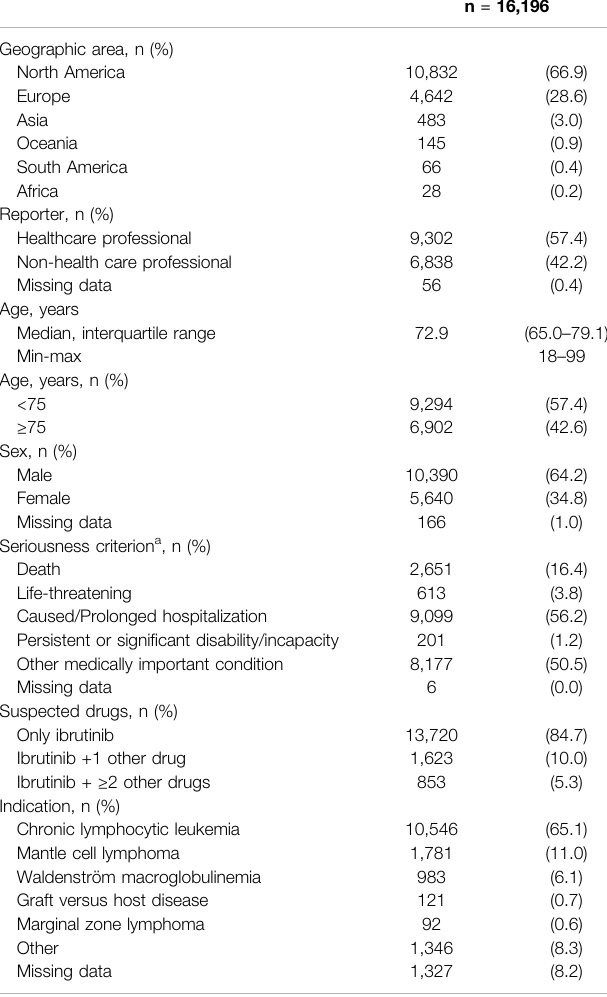
Table 2 . A total of 50 SDRs (4.9%) and 36 unique drug-event pairs were classi fi ed as potential safety signals ( Table 3 ).